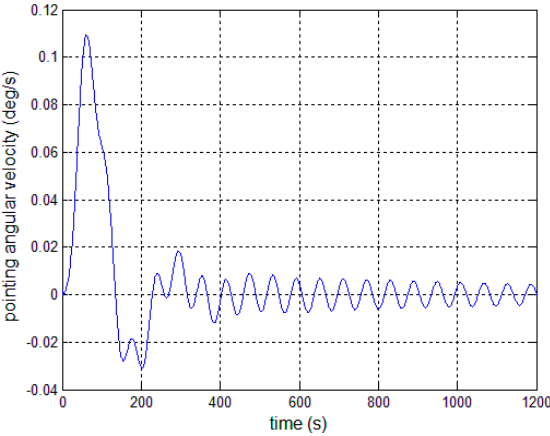
Figure 6. Antenna pitch angle error—controller (13).